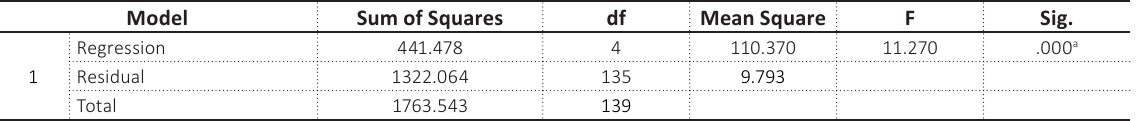
Table 7. Coefficients a